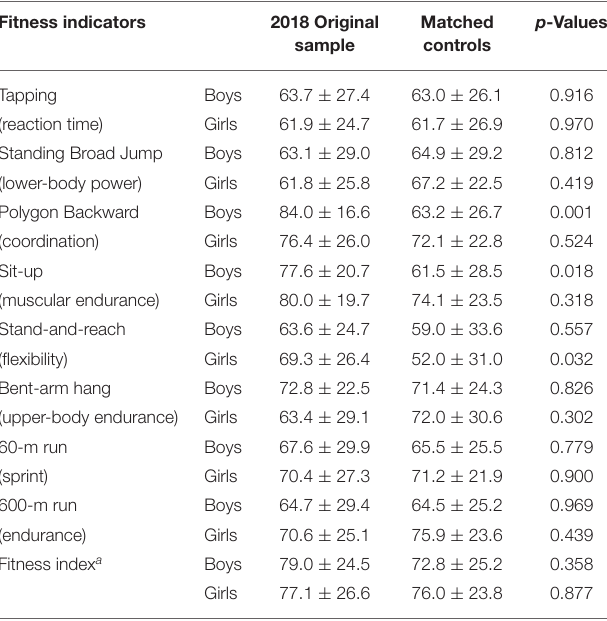
TABLE 4 | Centile values for the eight standardized fitness indicators for children initially recruited to participate in the project, and the matched controls extracted for Phase 2 physical fitness assessment portion of the